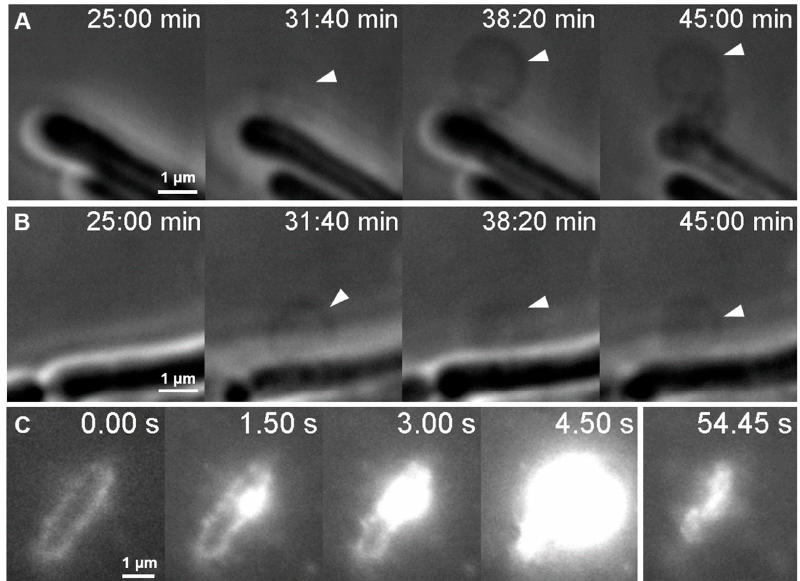
Figure 7. Viral infection induces blebbing and leads to explosive lysis. ( A ) and ( B ) show two exem- plary phase-contrast image series of bacterial blebbing. ( C ) A TIRF microscopy image series depict- ing certain moments from the lysis of a single bacterium in the presence of SyO. Timestamp starts from 35 min post-infection.